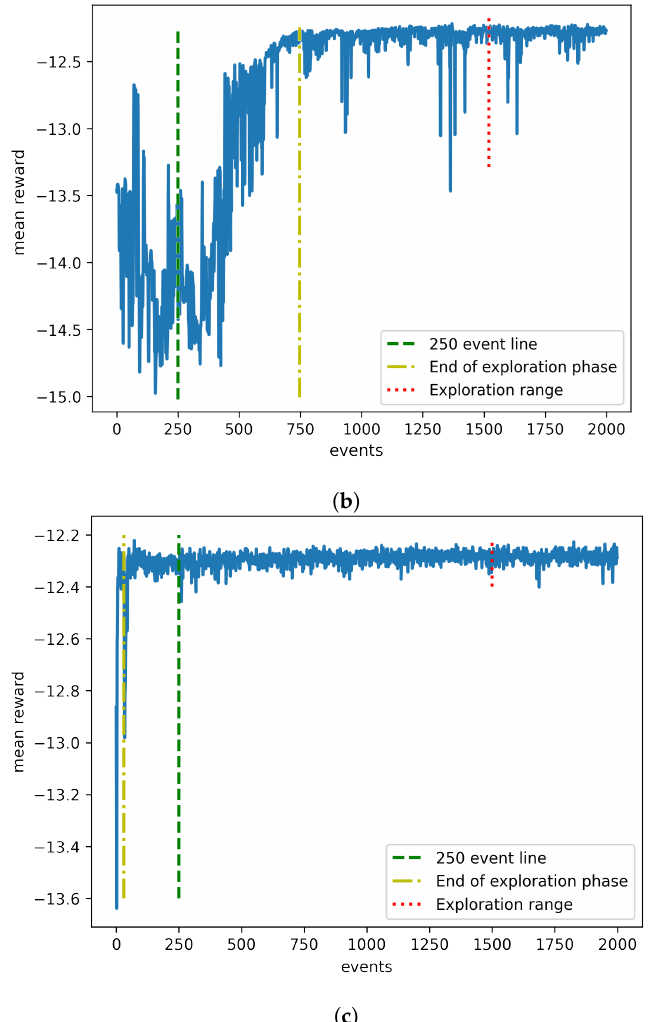
Figure 11. Comparison between the best three models, where the green line shows how the model is performing in an eighth of the training, the yellow line marks the end of the exploration phase, and the red line is the variation in exploration in the exploitation phase. ( a ) Model 1. ( b ) Model 2. ( c ) Model